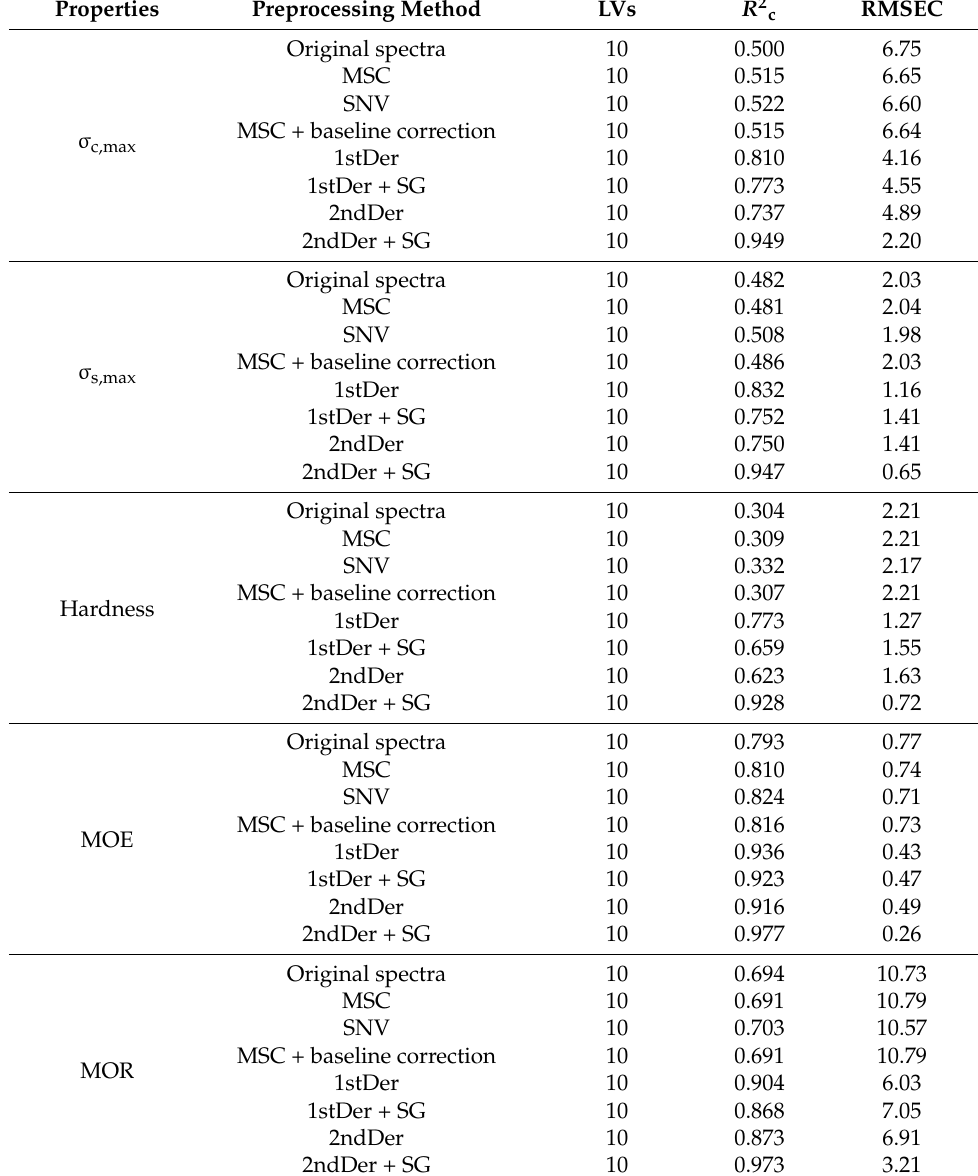
Table 3. PLSR model results with different preprocessing